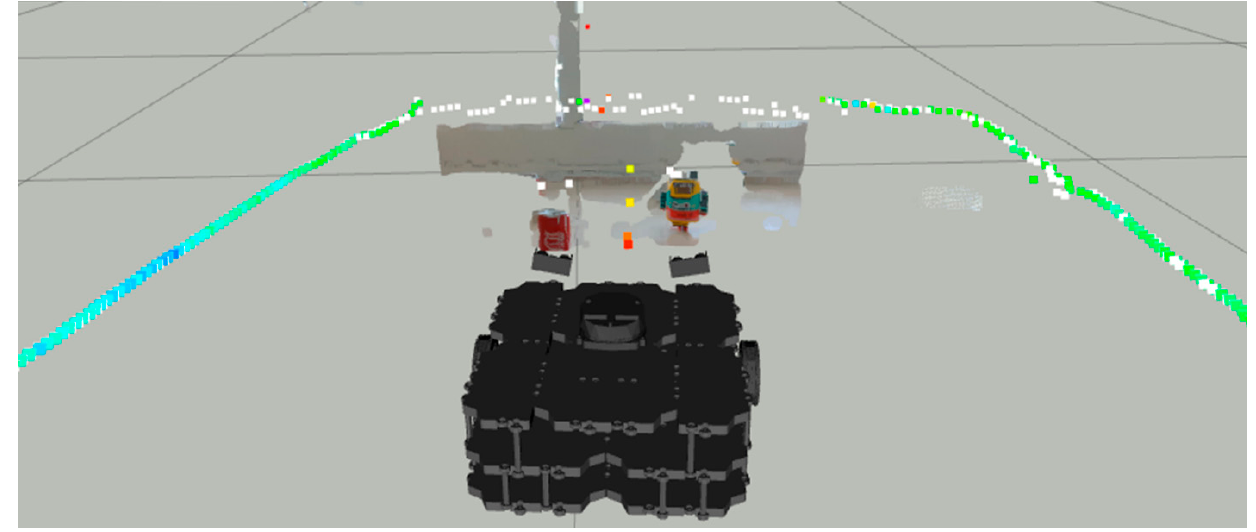
Figure 17. All sensors scanning region for LiDAR-Sonar-Camera fusion.